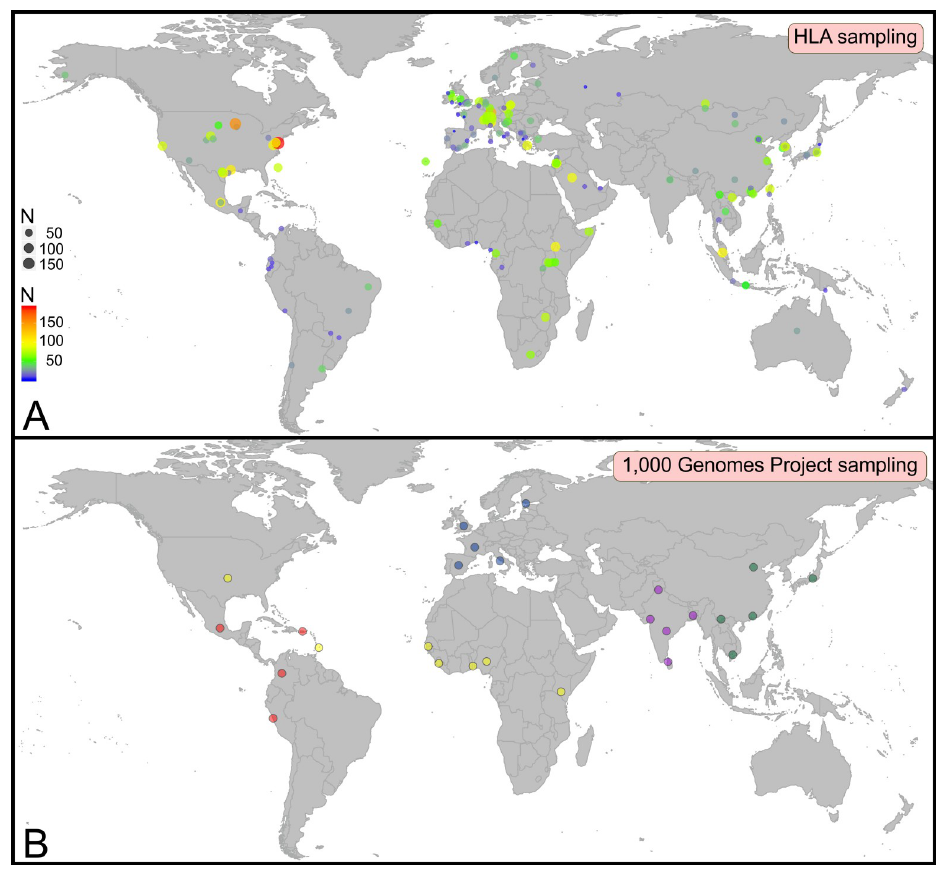
Fig 1. HLA sampling (A) is much more widespread than that of the 1,000 Genomes Project (B), which represents the current reference panel of human genomewide diversity. A. Circles represent the populations that were HLA typed. Colors and size of the circles correspond to the number of common alleles observed in each population (scales in the bottom left corner). B. Circles represent the region of origin for each of the 26 populations of the 1,000 Genomes Project. Each population has a color that corresponds to the associated geographical region: Europe (blue), Africa (yellow), Americas (red), South Asia (purple), and East Asia (green). A-B. Maps were generated using the ggplot2 package in R [16] and the world